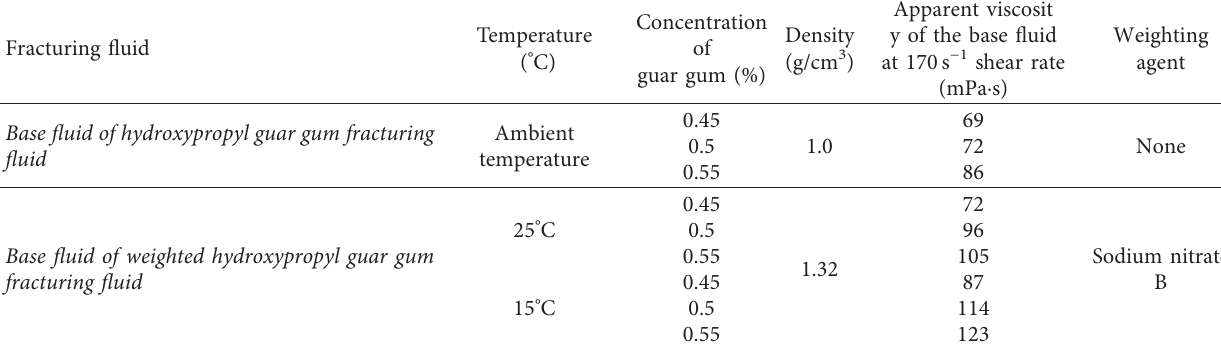
Table 4: Base fluid viscosity of different density fracturing fluids under different guar gum